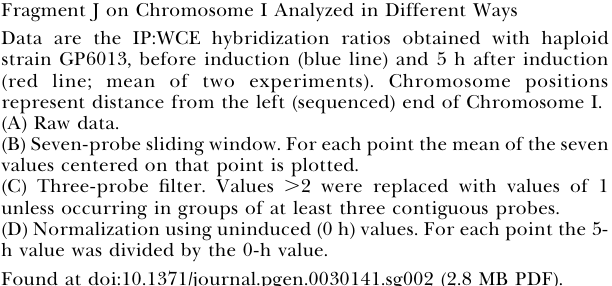
Figure S2. Comparison of Microarray Data Corresponding to the Not I Fragment J on Chromosome I Analyzed in Different Ways Data are the IP:WCE hybridization ratios obtained with haploid strain GP6013, before induction (blue line) and 5 h after induction (red line; mean of two experiments). Chromosome positions represent distance from the left (sequenced) end of Chromosome I. (A) Raw data. (B) Seven-probe sliding window. For each point the mean of the seven values centered on that point is plotted. (C) Three-probe filter. Values . 2 were replaced with values of 1 unless occurring in groups of at least three contiguous probes. (D) Normalization using uninduced (0 h) values. For each point the 5- h value was divided by the 0-h value. Found at doi:10.1371/journal.pgen.0030141.sg002 (2.8 MB PDF). Figure S3. Quantile-Quantile Plots of IP:WCE Hybridization Ratios (log 2 ) for Chromosome I from the Haploid Experiments (Strain GP6013) against Simulated Normal Values (with a Mean of 0 and Variance of 1) Uninduced (0 h) data are from haploid experiment 2; induced (5 h) data are the mean of two haploid experiments. Normally distributed IP:WCE hybridization ratios (log 2 ) should result in a straight line passing through the origin.